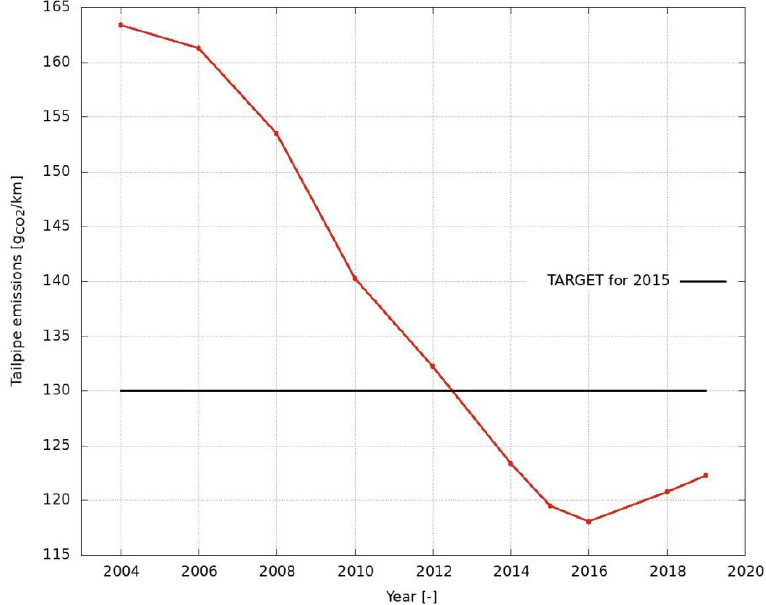
Figure 4. Average carbon dioxide emissions from new passenger cars in Europe [6].